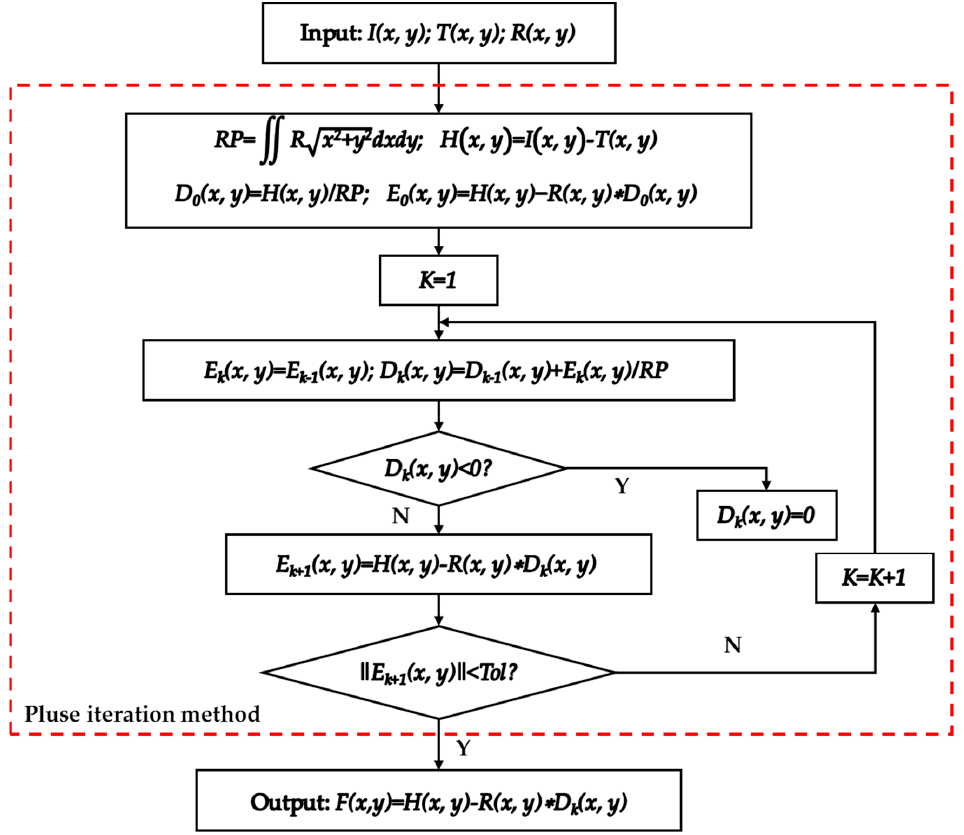
Figure 4. Flowchart for the pulse iteration method.